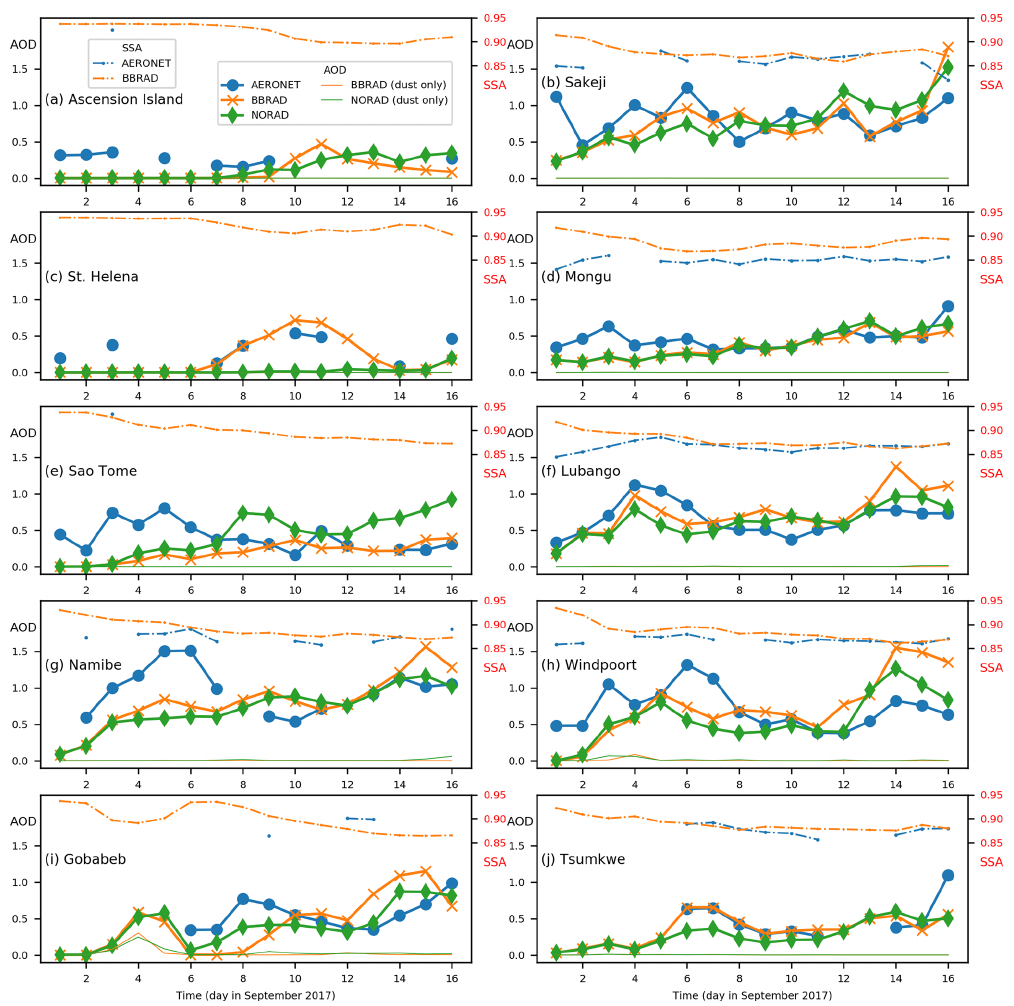
Figure 2. Time evolution of daily mean AOD at 532nm between 1 and 16 September 2017 from AERONET (blue), BBRAD (orange) and NORAD (green) at (a) Ascension Island, (b) Sakeji, (c) St. Helena, (d) Mongu, (e) São Tomé, (f) Lubango, (g) Namibe, (h) Windpoort, (i) Gobabeb and (j) Tsumkwe. The orange and green thin lines show the AOD due to dust for BBRAD and NORAD simulations, respectively. The blue and orange dotted lines show the SSA at 440nm for AERONET and BBRAD, respectively. Results are shown for the BBRAD and NORAD members starting at 00:00UTC on 1 September